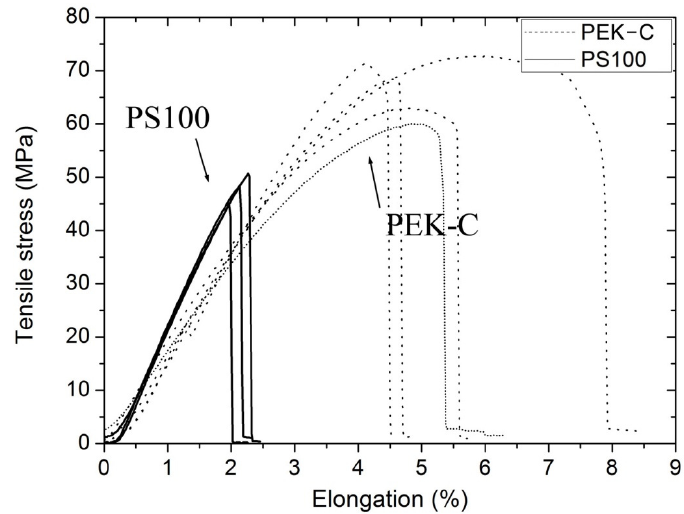
Figure 4. Tensile curves of PEK-C films and PS100 films.